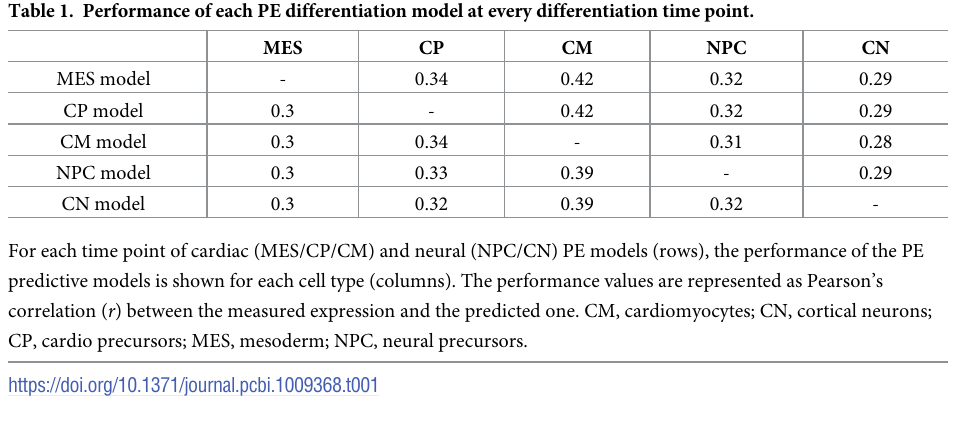
Table 1. Performance of each PE differentiation model at every differentiation time point. MES CP